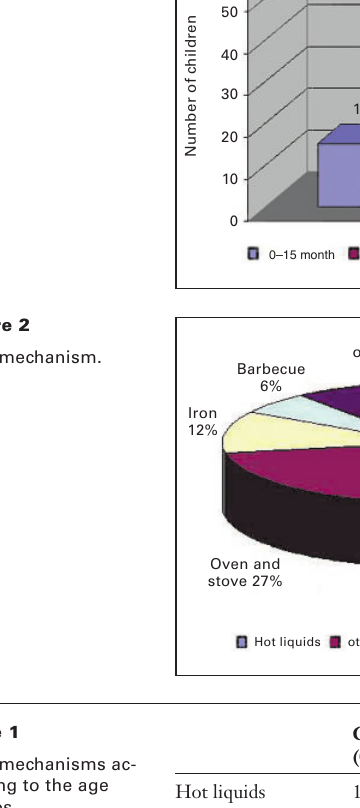
Burn mechanisms ac- cording to the age